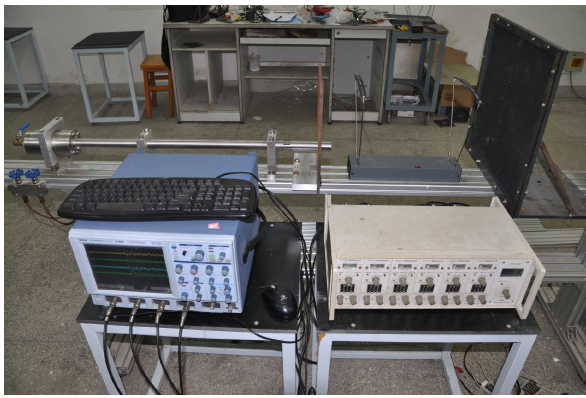
Figure 4: Waveforms of signals collected by strain gauges